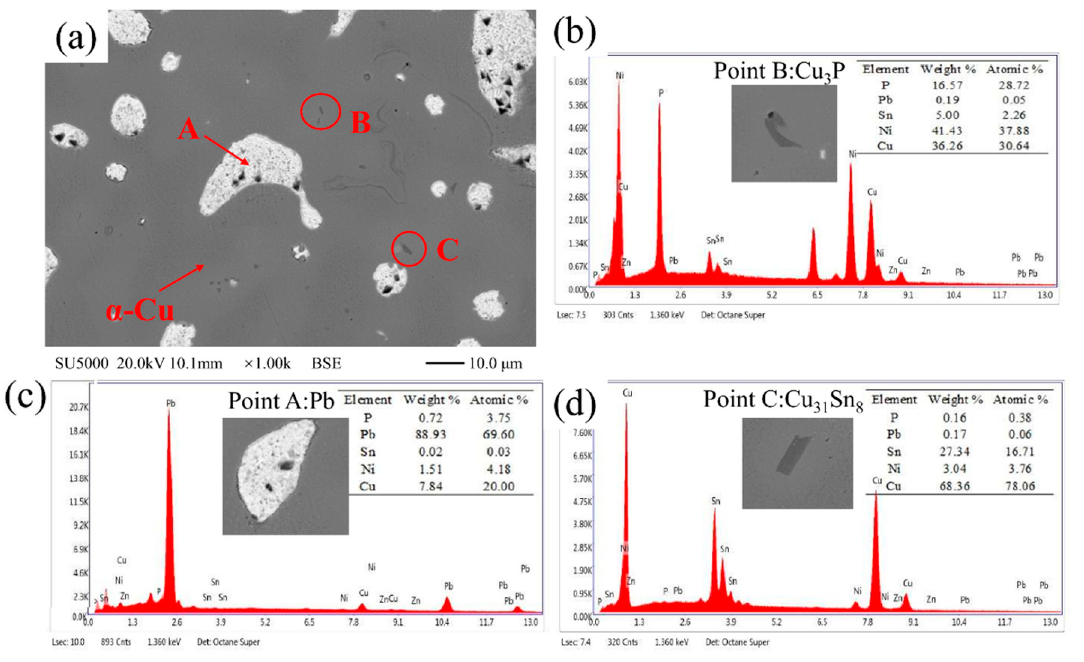
Figure 7. The copper layer phase composition. ( a ) BSE microstructure, ( b ) EDS at point B in ( a ), ( c ) EDS at point A in ( a ), and ( d ) EDS at point C in ( a ).